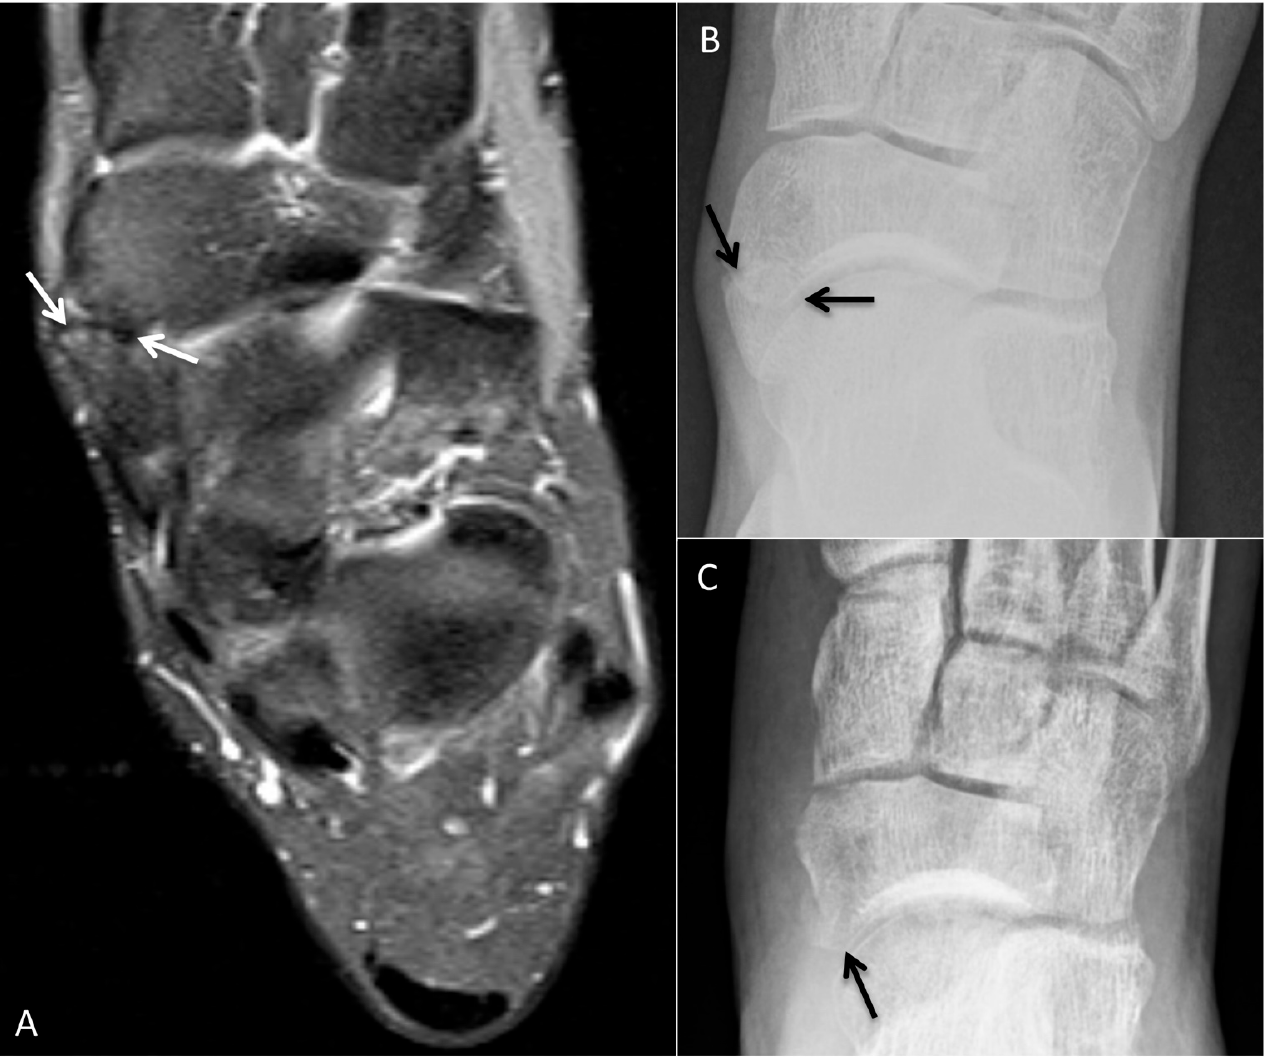
Figure 8. Pre- and postoperative images in a patient with a symptomatic accessory navicular. ( A ) Preoperative axial PD fat-suppressed MR image with mild edema/degenerative changes at the accessory navicular synchondrosis (arrow). ( B ) Preoperative radiograph with type II accessory navicular (arrows). ( C ) Postoperative changes from accessory navicular resection without complication (arrow).